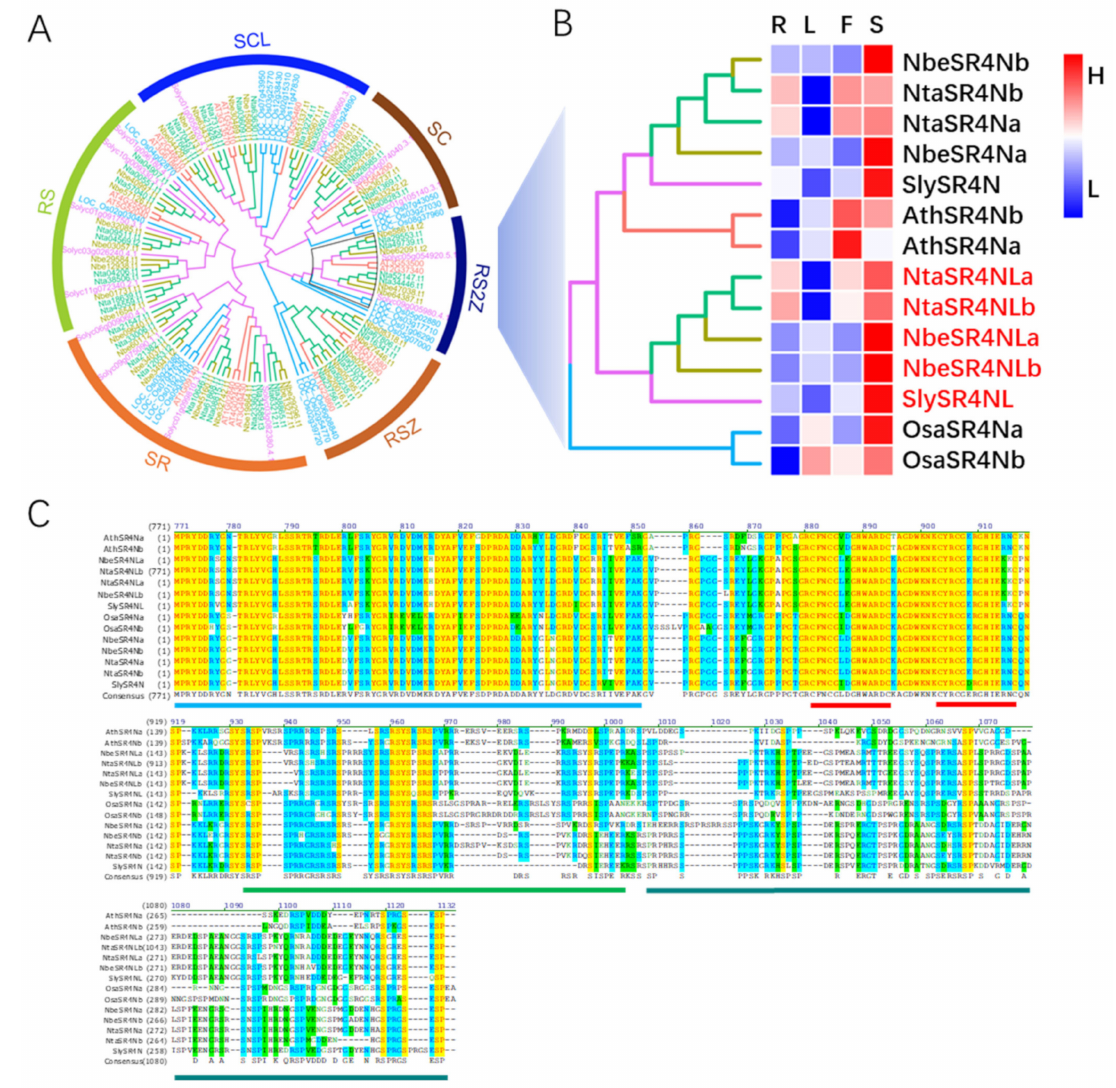
Figure 5. SR4N is conserved in both monocots and dicots. ( A ) Phylogeny tree of SR protein family from rice (blue IDs), Arabidopsis (orange IDs), tomato (purple IDs), and tobacco (green IDs) genomes. ( B ) Expression heatmap of RS2Z subclade members. Published RNA-seq data were obtained and analyzed (see Section 2.6). Sample sources are indicated on top of the heatmap: R, root; L, leaf; F, flower; S, seed. Gene IDs are indicated to the right. ( C ) Protein sequence alignments for the RS2Z subclade proteins. Blue line marks the RRM motif; red lines mark the zinc finger motifs; green line marks the serine/arginine-rich region; dark blue line marks the serine/proline-rich